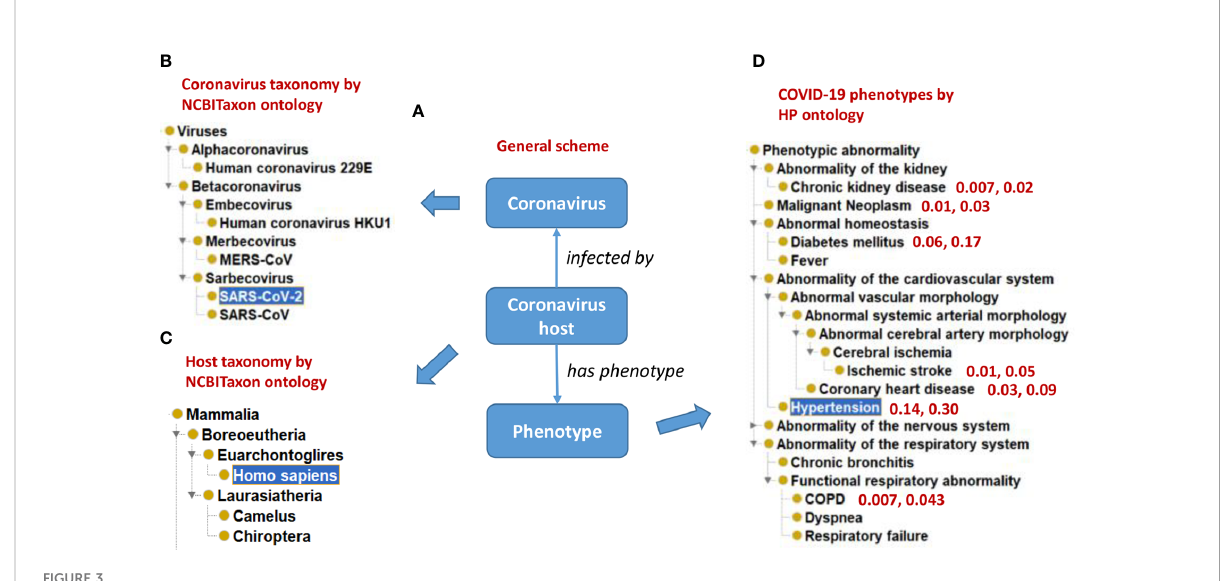
FIGURE 3 Ontological representation of coronaviruses, hosts, and phenotype outcomes of host-coronavirus interactions. (A) A general scheme. (B) The NCBITaxon taxonomical hierarchy of representative human coronaviruses. (C) The taxonomical hierarchy of representative hosts of coronaviruses. (D) Human Phenotype Ontology (HPO) hierarchy of representative human phenotypes commonly seen in COVID-19 patients. Representative comorbidity phenotypes and associated phenotype frequency in mild and severe COVID-19 patients are also represented. For example, “ 0.14, 0.30 ” in (D) indicates that superimposed hypertension is found in 14% of mild symptom patients and 30% of severe symptom patients. The results were summarized from reported literature (58,